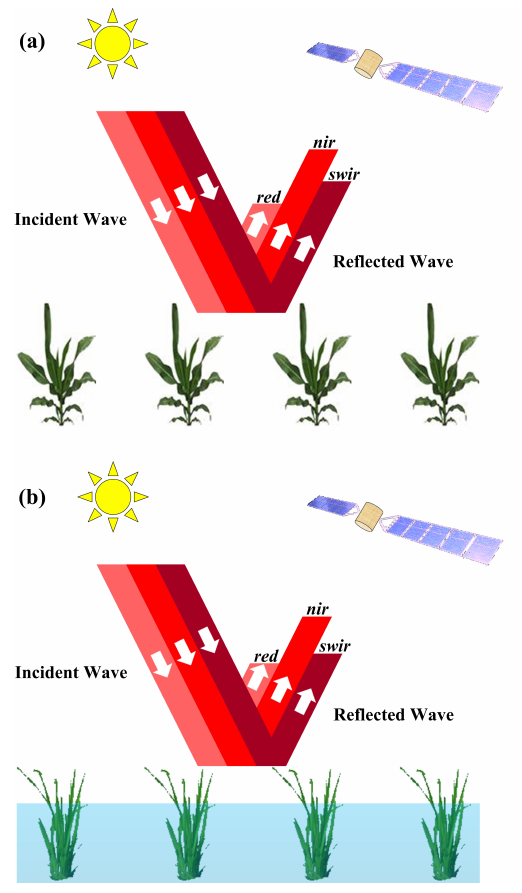
Figure 2. Reflectance characteristics in the red, near-infrared (nir), and short-wave-infrared (swir) bands for (a) non-flooded cropland (maize field) and (b) flooded rice field. The water-sensitive index LSWI is compared with the biomass- sensitive indices NDVI and EVI to distinguish flooded rice fields from other